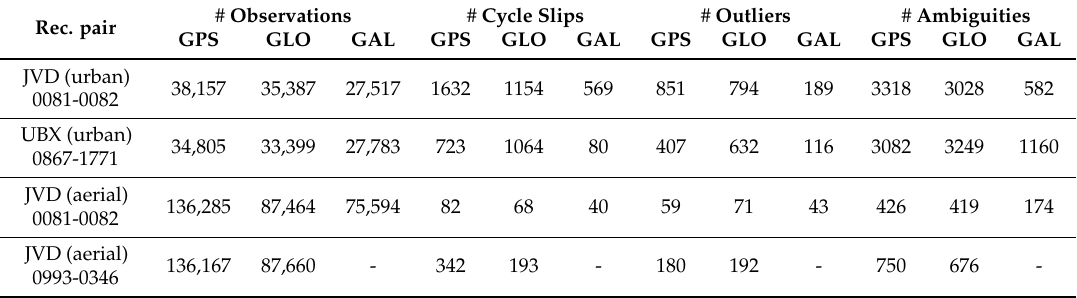
Table 4. GNSS L1 DD computation statistics for different receiver combinations from both experiments. Rec.